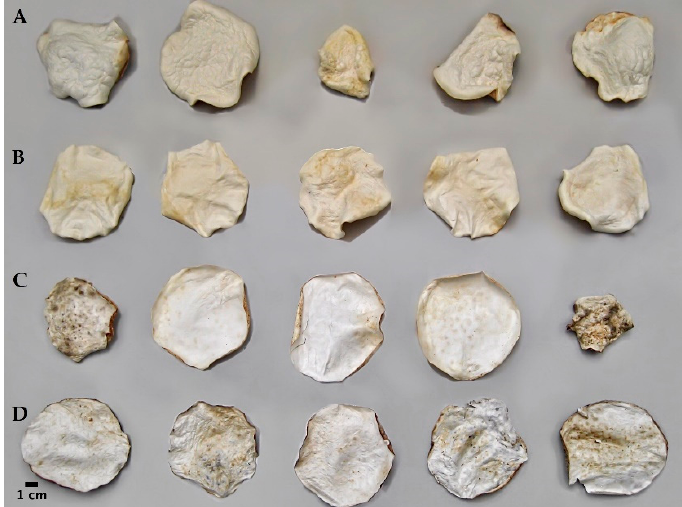
Figure 2. Dry mycelial mats obtained by Mogu’s patented method after 3 weeks of growth in Petri plates; five repetitions were conducted per strain: ( A ) Fomitopsis iberica (10), ( B ) Daedaleopsis confragosa (6), ( C ) Coriolopsis gallica (3), and ( D ) Terana caerulea (19).